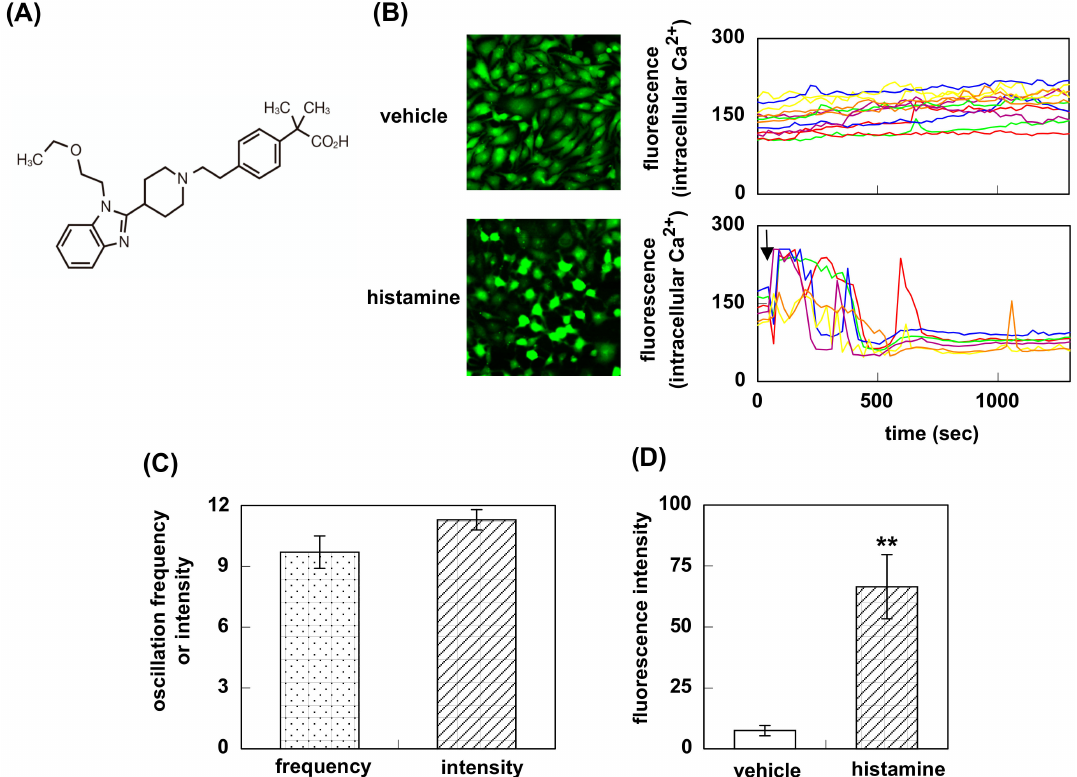
Figure 1. Intracellular Ca 2 + elevation in HeLa cells. ( A ) Structure of bilastine. ( B ) HeLa cells were stimulated with 1 mM histamine (or vehicle) and intracellular Ca 2 + was monitored for 20 min at 22 sec intervals. In ( C ), oscillation frequency and oscillation intensity for 20 min were counted from the data from vehicle-treated cells. Data are expressed as means ± SEM ( n = 12). In ( D ), fluorescence intensity during 2 min after histamine (or vehicle) stimulation was calculated. Arrow shows the time for histamine stimulation. Data are expressed as means ± SEM ( n = 6 or 12). **, p < 0.01 vs.